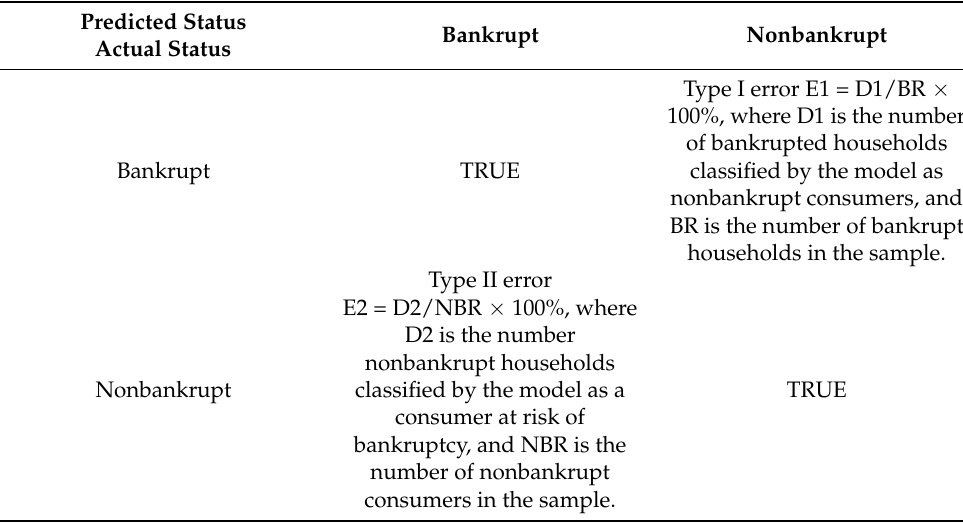
Table 3. Classification matrix of statistical forecasting models. Source: based on own